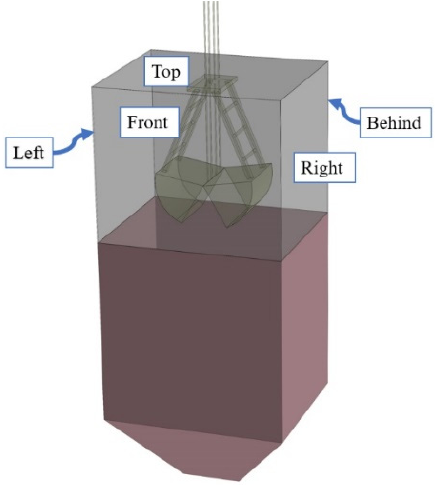
Figure 5. Schematic diagram of five planes above the hopper.